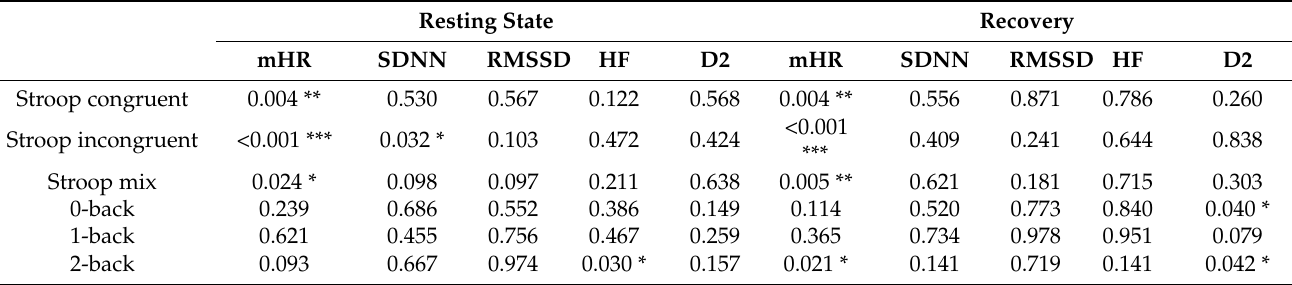
Figure 6. Means and group × condition interactions for D2. Error bars indicate ±2 standard error of mean. * p < 0.05. Table 3. Interaction p -values (group as between-participants factor). Resting State